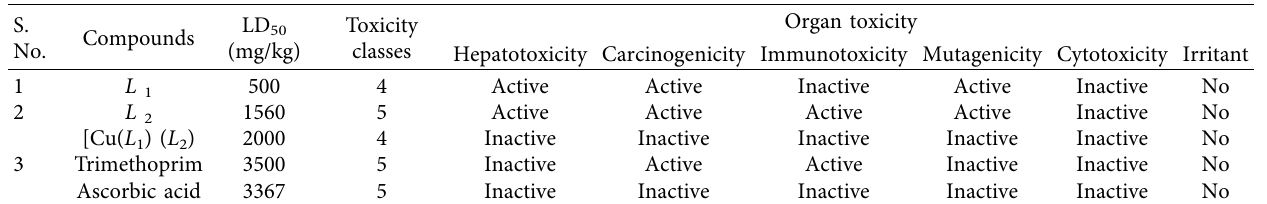
Table 8: Toxicity